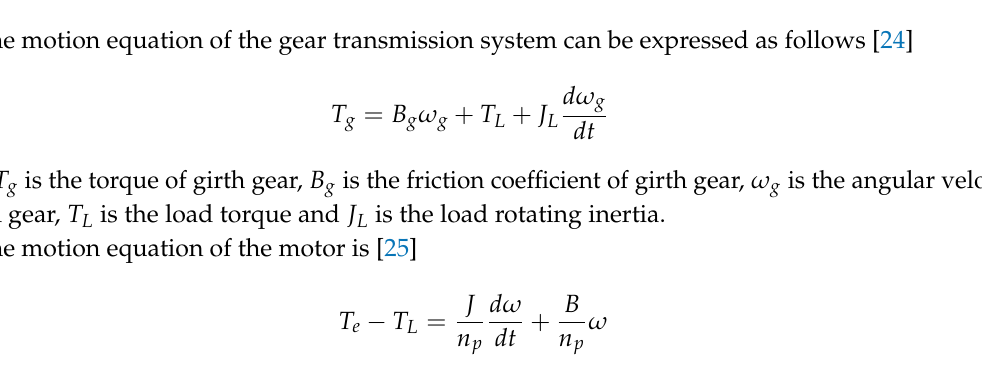
Figure 3. Dual-motor-driven transmission system.